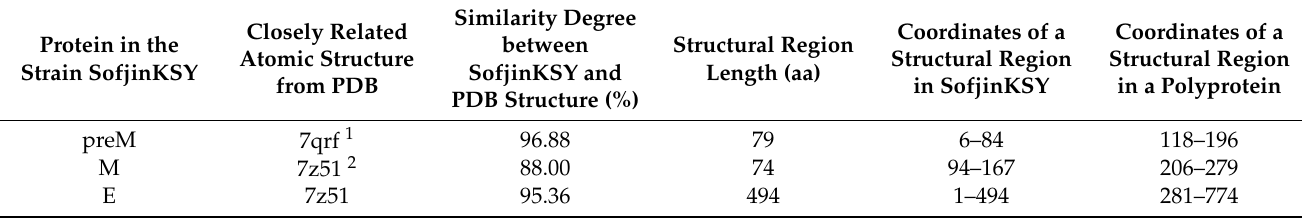
Table 2. Information on Reconstruction of 3D structures of TBEV proteins, the template strain SofjinKSY (AEP25267.2).